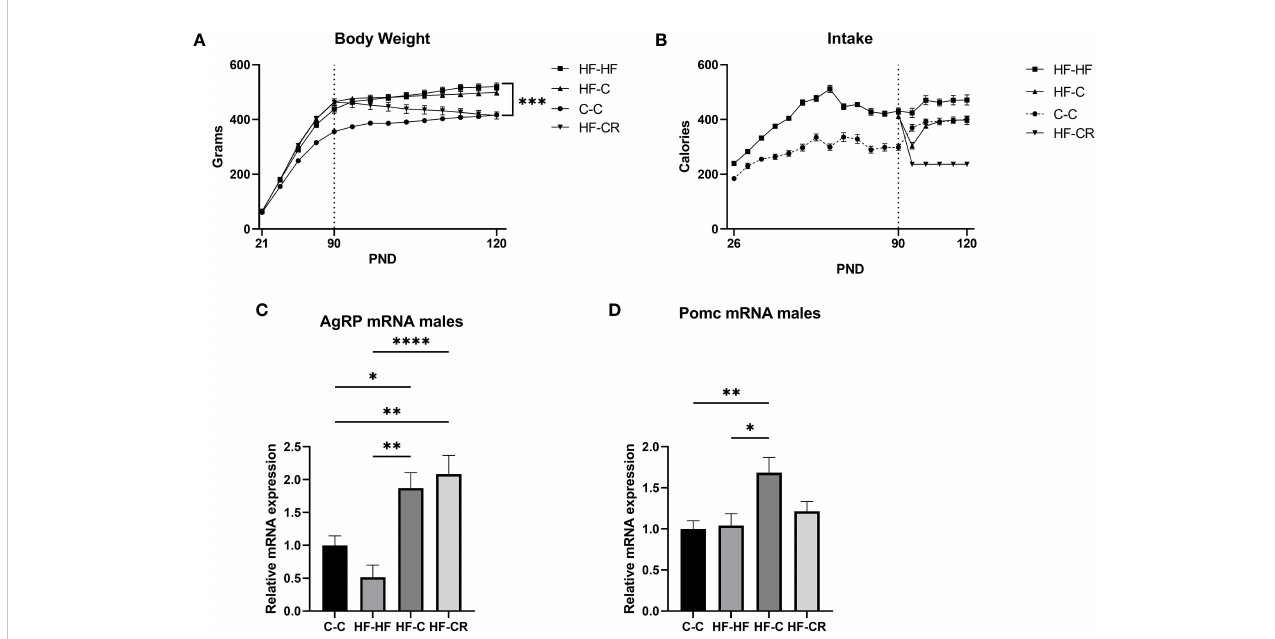
FIGURE 2 Caloric restriction results in reduction of body weight and changes in classic-energy balanced gene expression in the ARC of diet-induced obese male rats. (A) The average body weight (grams) throughout the duration of the experiment. In Phase I, rats were weighed every 5 days and weighed daily in Phase II. (B) Average caloric intake (kCal) throughout the duration of the experiment, measured by the weight difference of food remaining in the cages over 5 days during Phase I and daily in Phase II (Chow: 1 g = 3.1 kCal; HFD: 1 g = 5.24 kCal). Gene expression of the ARC was measured using RT-qPCR with primers designed for (C) AgRP and (D) Pomc. Hprt expression was used as the standard gene to normalize all results. Relative gene expression in the C-C group was set to 1. Data are presented as mean ± SEM, and signi fi cant effects between groups are indicated as * 0.01 < P < 0.05, **0.001 < P < 0.01, **** P <